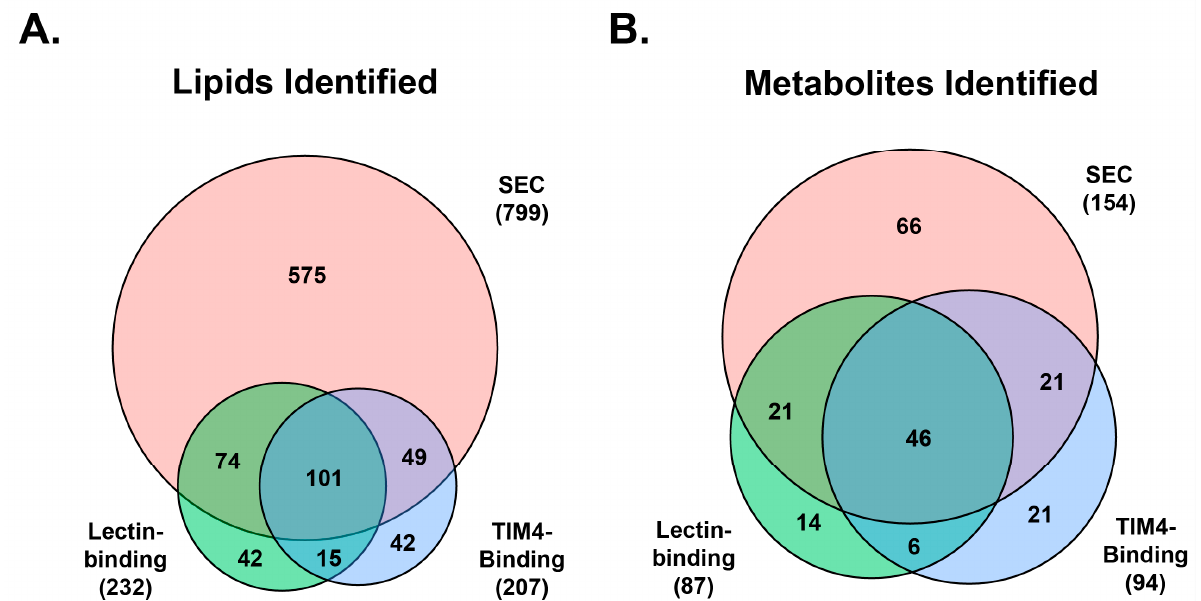
Figure 3. Overlap in identified lipids ( A ) and metabolites ( B ) for the 3 exosome extraction methods.